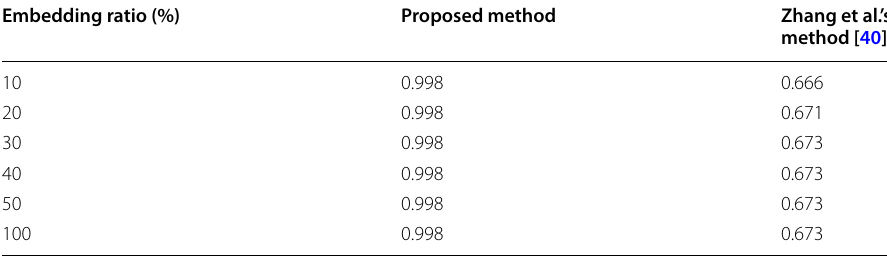
Table 6 Comparison of the precision of methods for the BOSS image database Embedding ratio (%)